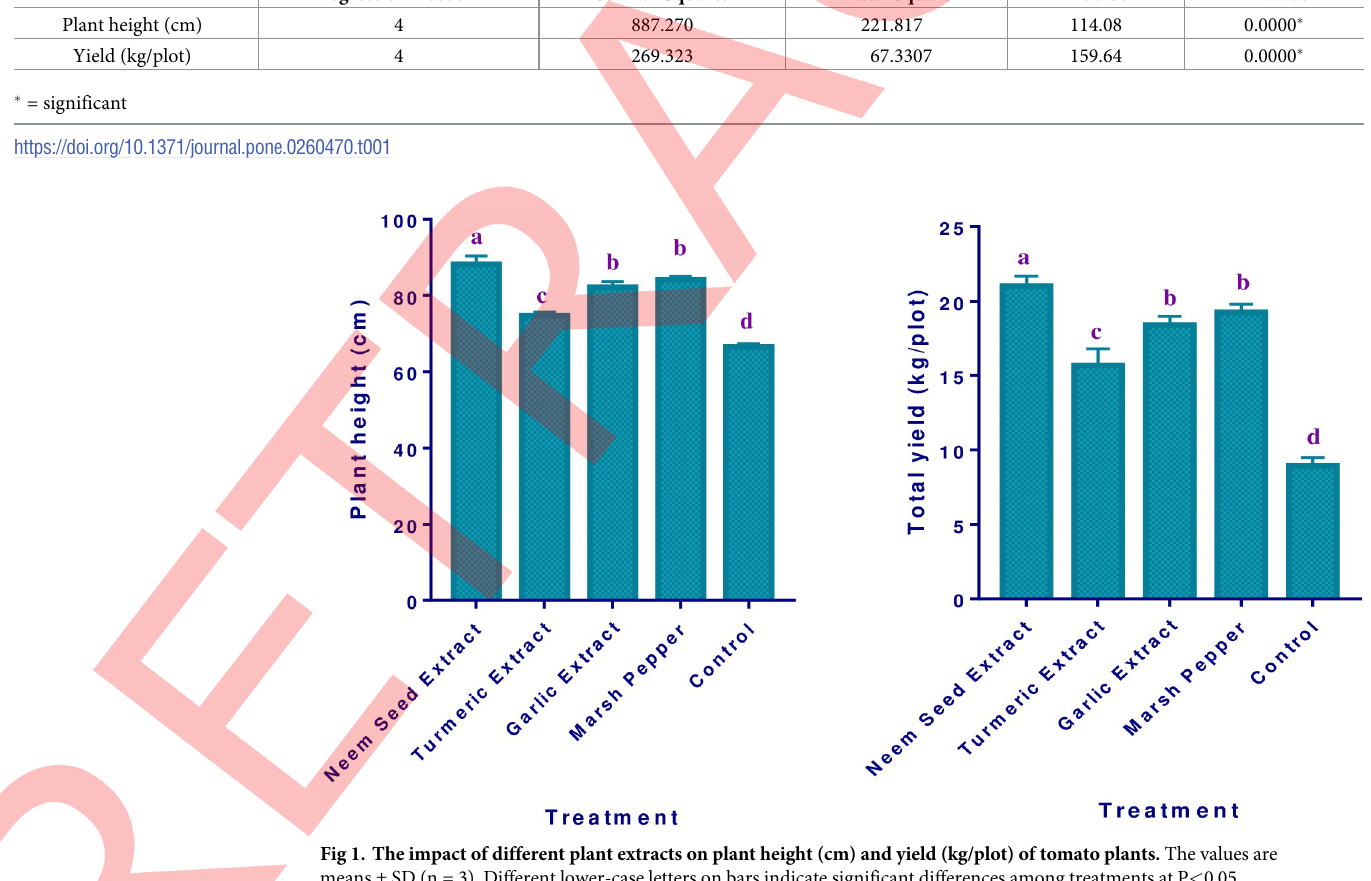
Table 1. Analysis of variance for effect of natural insecticides on height (cm) and yield (Kg/plot) of tomato. Degrees of Freedom Sum-of-Squares Mean Square F Value P-Value Plant height (cm)